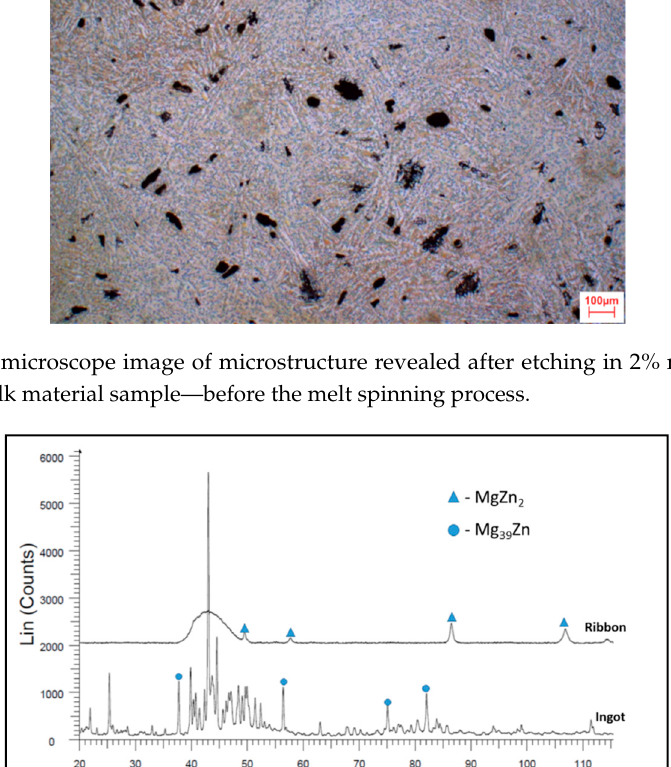
Figure 4. X-ray diffraction results for Mg 72 Zn 24 Ca 4 alloy samples.